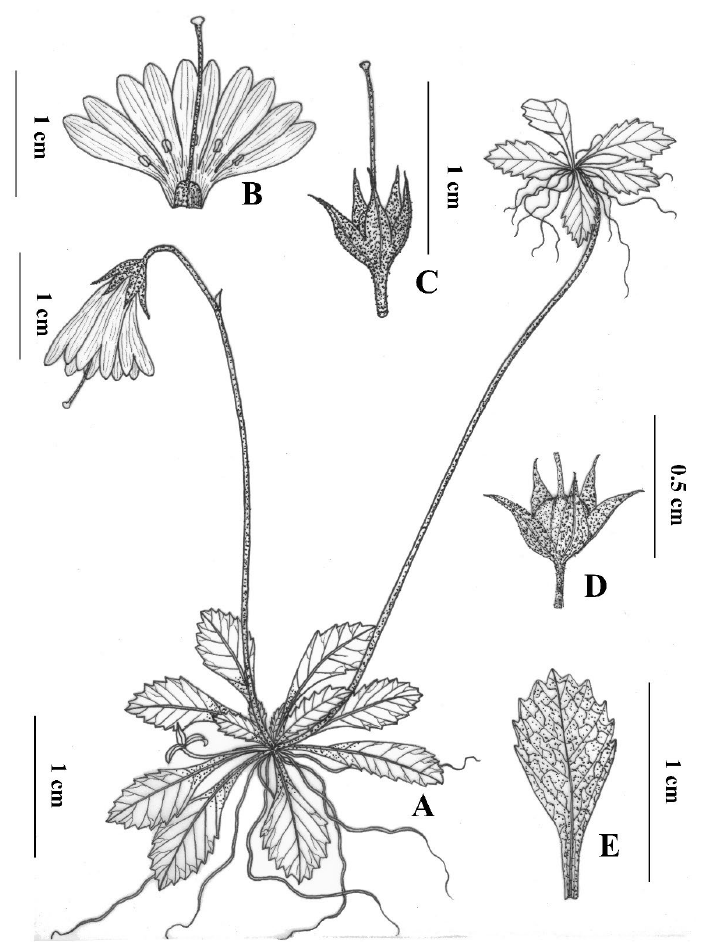
Figure 1. Primula luquanensis sp. nov.: ( A ) habit; ( B ) dissected corolla showing floral form; ( C ) calyx and style; ( D ) calyx and fruit; ( E ) abaxial view of the leaf.